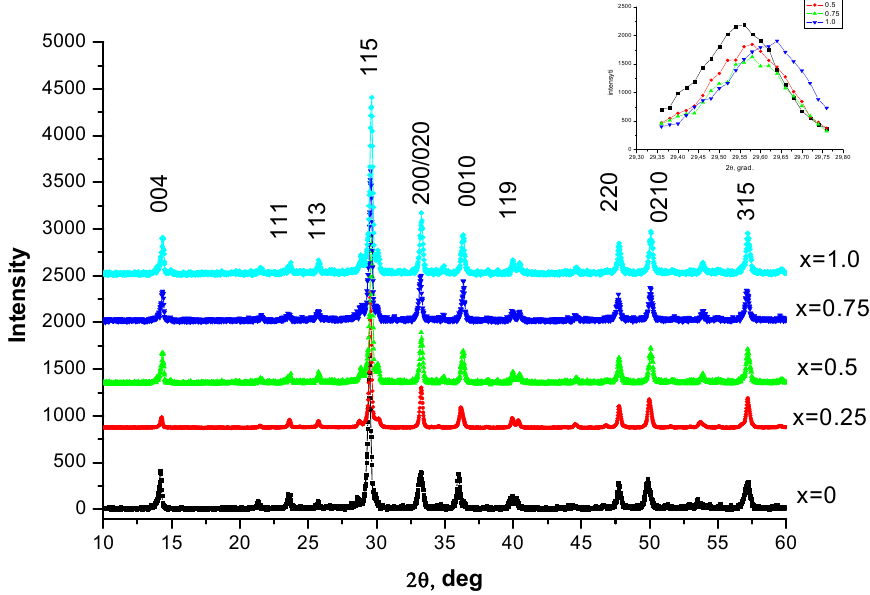
x=0.25x=0.5x=0.75